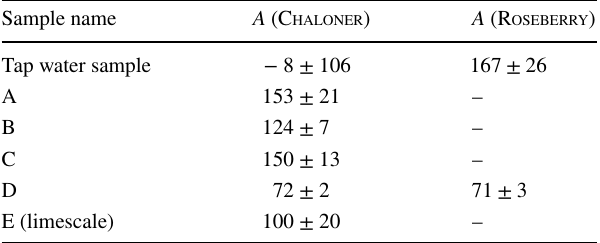
Table 5 Measured 40 K concentrated specific activities A in all open water samples, in